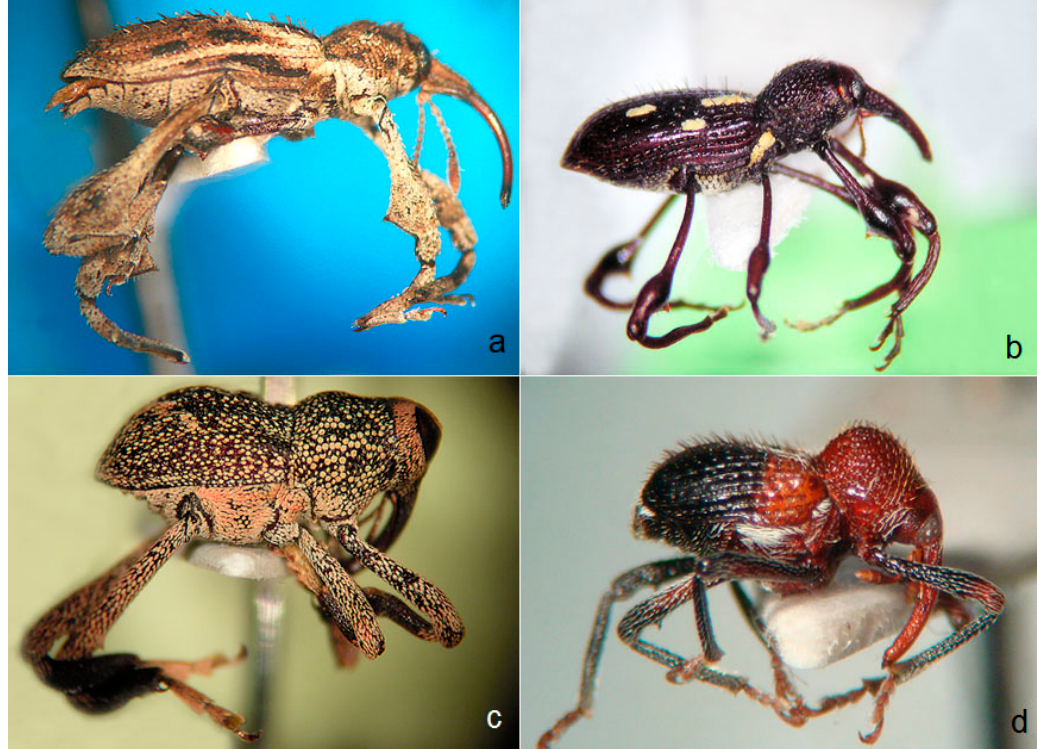
Figure 8. Long-legged weevils. Long legs may be an adaptation to life in the canopy and were mainly found in Curculionini (see Figure 4), Trachodini and Conoderinae, e.g., Acicnemis ( a ); Pseuderodiscus ( b ); Odoacis ( c ); and Talimanus ( d ). More than 60 Trachodini morphotypes were recognized.